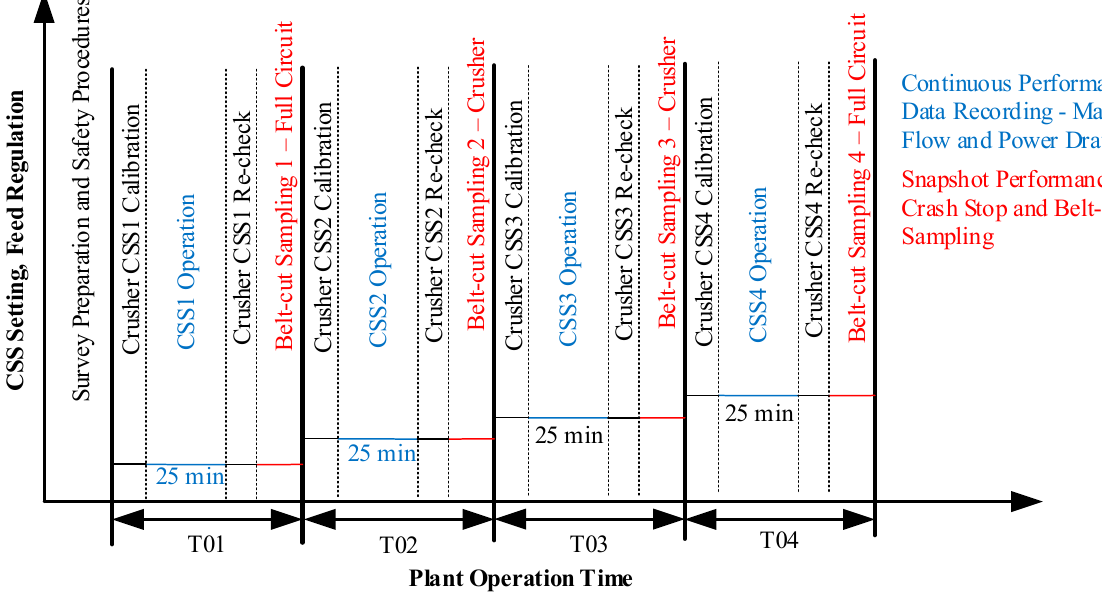
Figure 7. Experimental sequence applied for mapping the circuit performance of the crushing plant. Table 1. Experimental noted values for the crushing plant.